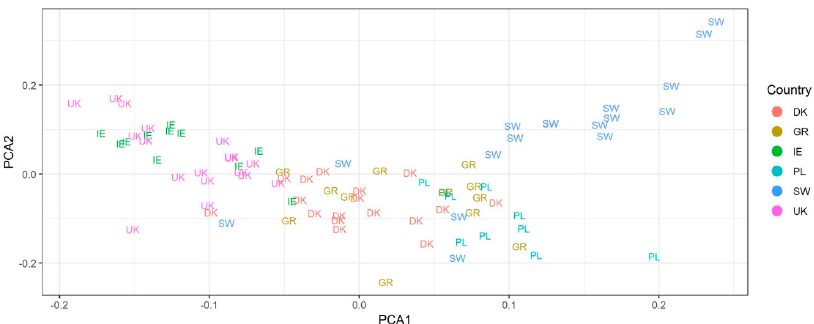
Figure 3. Principal coordinate analysis (PCA) analysis of Dactylis glomerata GBS data. Samples from different countries overlap but clustering of genotypes relative to geography is evident with Ireland and the UK on the left, Germany and Denmark central and Poland and Sweden on the right (and also split on axis